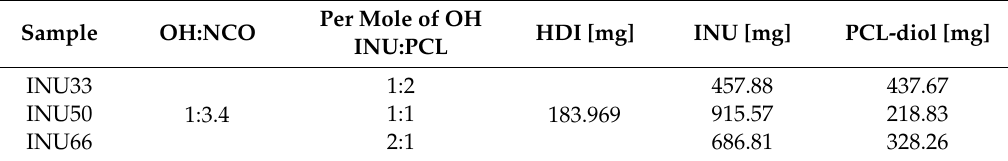
Table 1. Molar ratios between polyol:isocyanate precursor and the amount of precursor used for synthesized inulin-based polyurethane